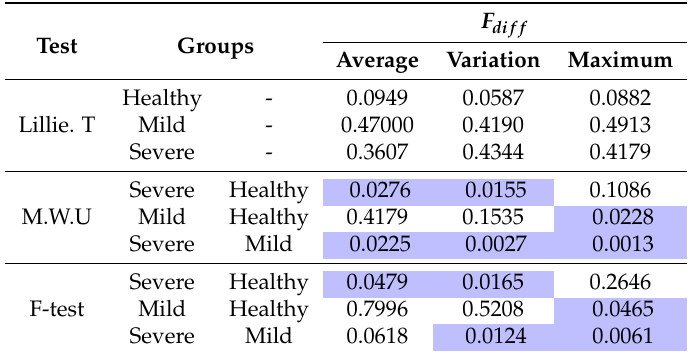
Table 1. Lilliefors test/Mann–Whitney U (M.W.U.) test/F-Test p -values. The null hypotheses rejection are been